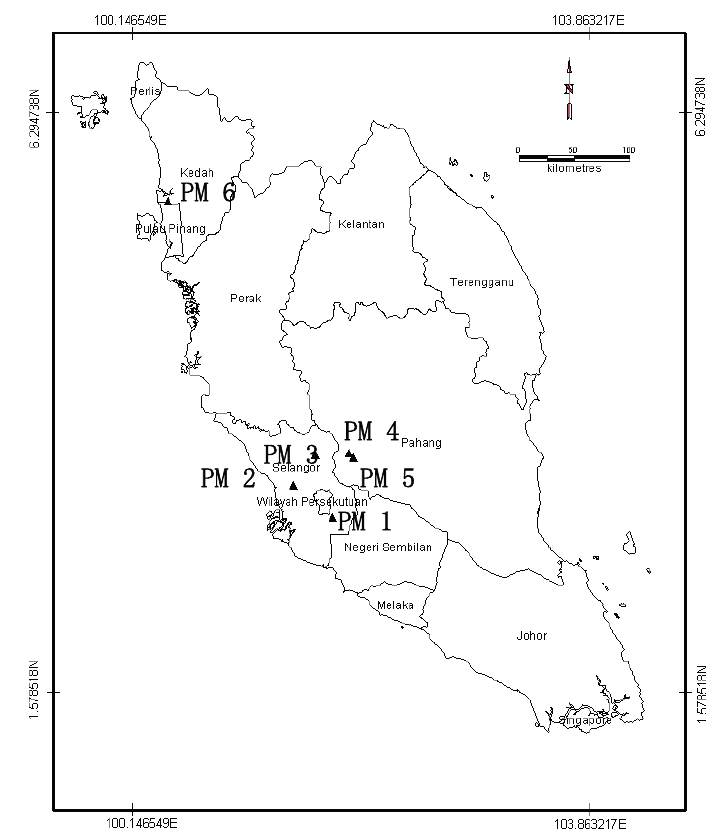
Figure 1. Map of the sampling locations in Peninsular Malaysia for the paper mill sludges used in this